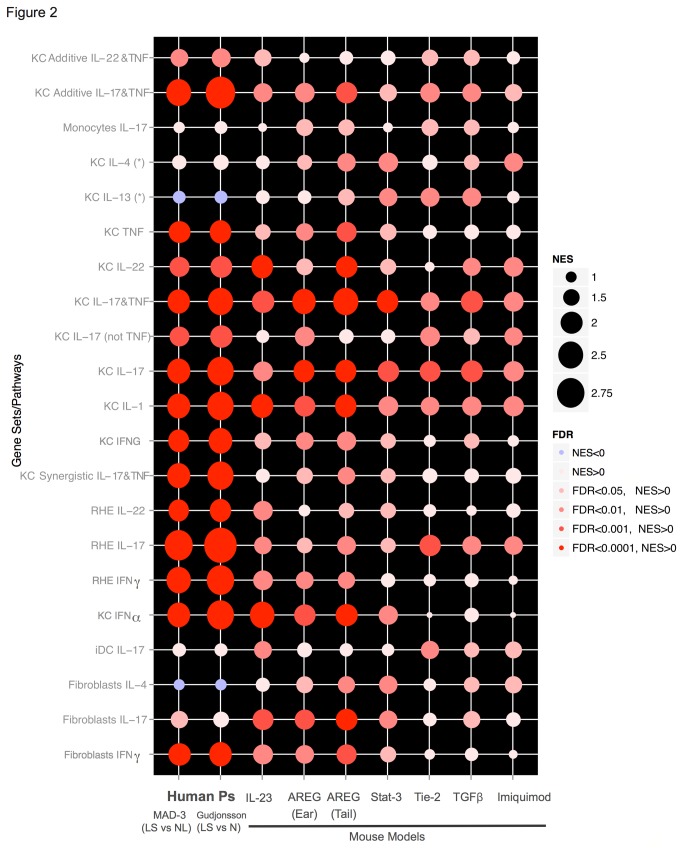
Pathways enriched in human psoriasis and inflammatory mouse model transcriptomes with GSEA.Degree of enrichment of key inflammatory pathways implicated in psoriasis pathogenesis compared in human and murine transcriptomes is portrayed by the bubbles representing normalized enrichment score (NES) and false discovery rate (FDR) values. Six inflammatory mouse model transcriptomes; IL-23-induced (IL-23), K14-AREG (AREG for both ear and tail), K5-Stat3c (Stat3), K5Tie2 (Tie-2), K5-TGFβ1 (TGFβ) and IMQ as well as two human psoriasis transcriptomes; MAD3 and Gudjonsson(LSvsNormal), were queried with sets of cytokine-treated keratinocyte, monocyte, fibroblast, inflammatory DC and reconstituted human epidermis (RHE) pathways.